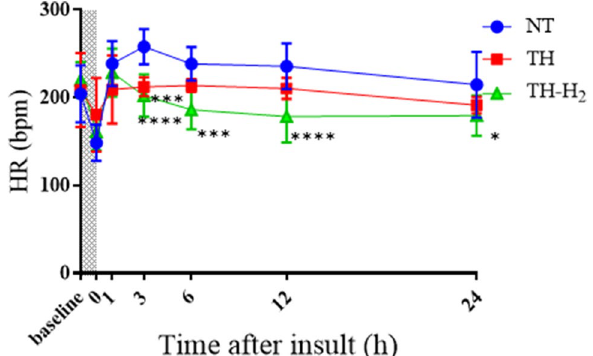
Figure 3. Heart rate (bpm) at the end and at 1, 3, 6, 12, and 24 h after hypoxic-ischemic insult in normothermia (NT, n = 10), therapeutic hypothermia (TH, n = 8), and TH with hydrogen gas inhalation (TH + H 2, n = 8) groups. Shaded areas indicate the hypoxic-ischemic insult period. Data are means ± SD in the NT group (blue circle), TH group (red square), and TH + H 2 gas group (green triangle). * p < 0.05, ** p < 0.01, *** p < 0.001, **** p < 0.0001 vs. the NT group.